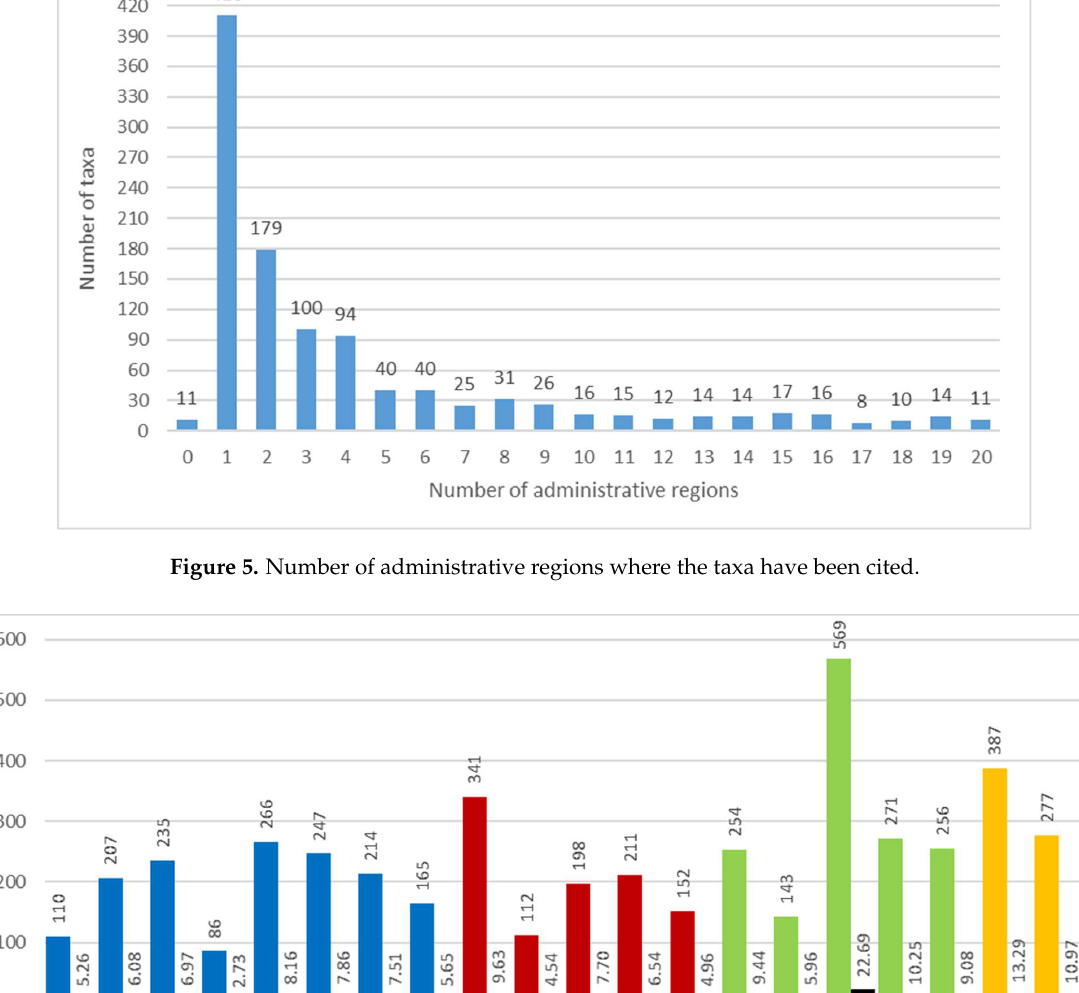
Table 5. Number of taxa excluded from the calculation of WEPs and reason for exclusion Reason for